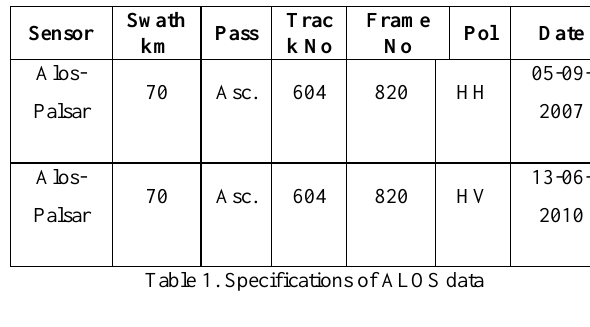
Table 1. Specifications of ALOS data